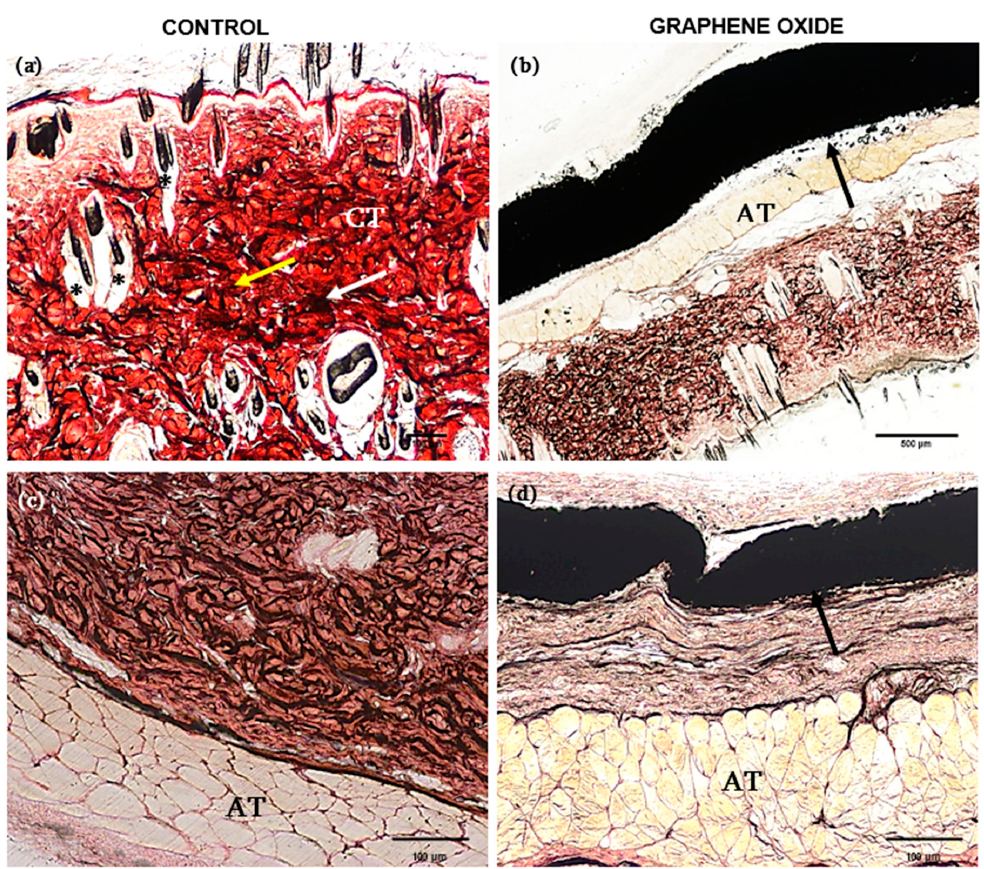
Figure 4. Skin histological section (control sample) stained with Masson’s Trichrome ( a ) and HE ( c ), respectively, showing the dense unmodeled connective tissue (CT), collagen fibers (yellow arrow), elastic fibers (white arrow) and hair follicle (*), scale bar: 100 µm ( a ); Skin histological section with GO e (black arrow) stained with Masson’s Trichrome, highlighting the dense unmodeled connective tissue (CT) and adipose tissue (AT), scale bar: 500 µm ( b ) and HE ( d ) respectively, scale bar: 100 µm.